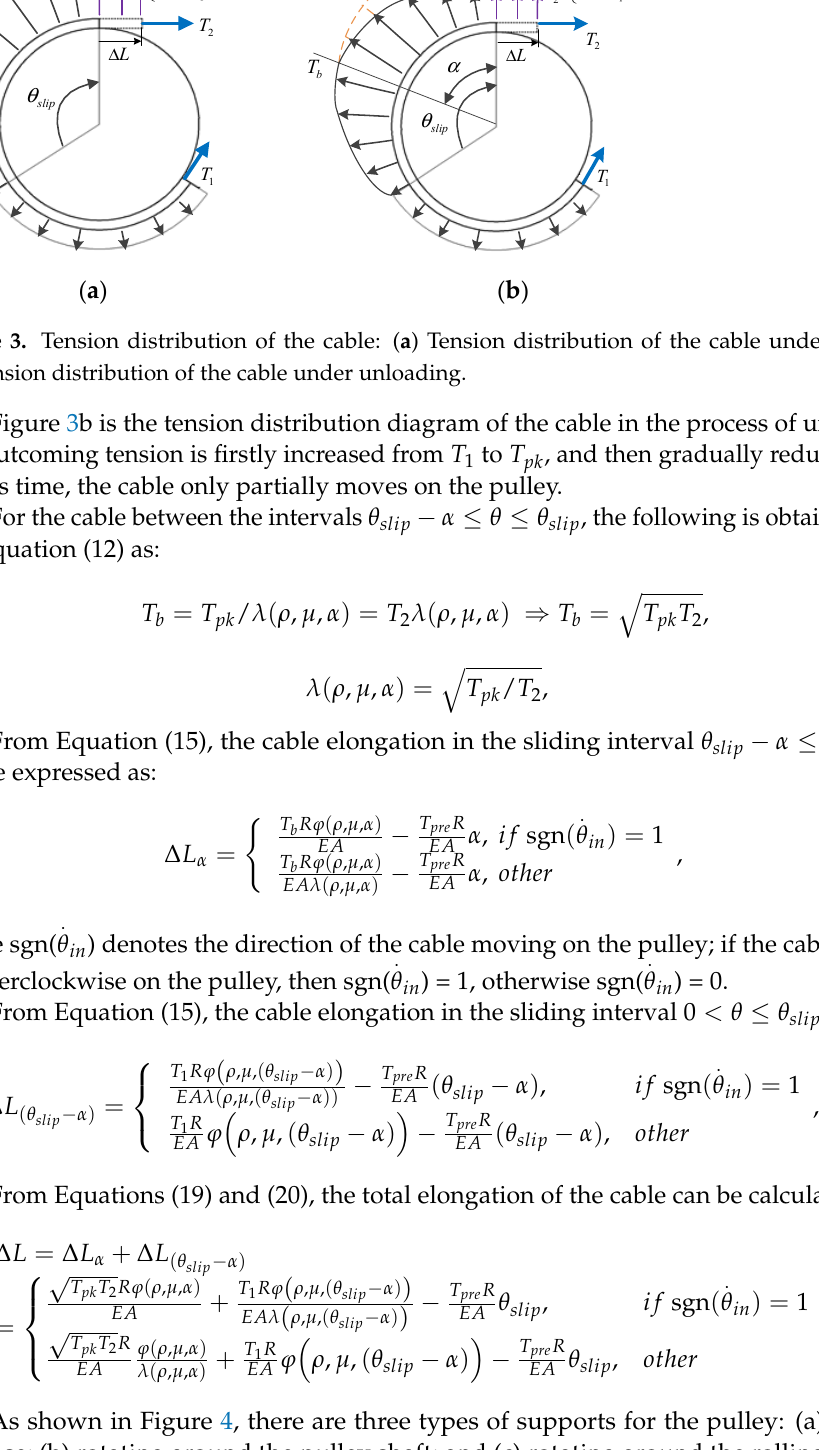
. Figure 3b is the tension distribution diagram of the cable in the process of unloading. The outcoming tension is firstly increased from 1 T to